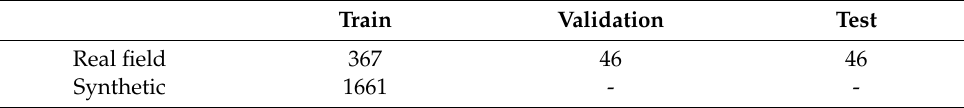
Figure A2. Experimental results of each model on the synthetic dataset. ( a ) mAP @0 . 5 curves for the synthetic dataset. ( b ) Loss curves for the synthetic dataset.